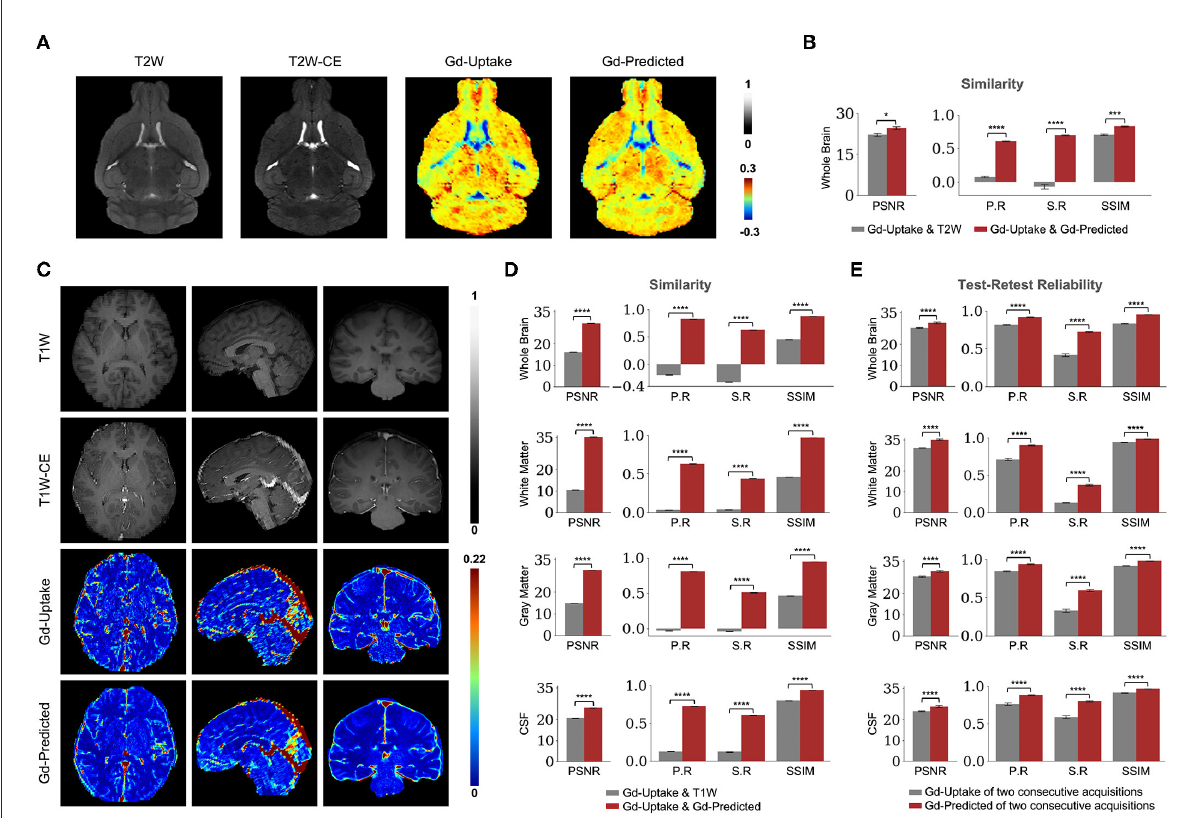
FIGURE3 Quantitative evaluation of the DeepContrast in the healthy mouse and human brains. (A) DeepContrast prediction (Gd-Predicted) highly concords with the ground truth GBCA-uptake map (Gd-Uptake) in the mouse brain. The non-contrast scans and the contrast-enhanced scans are displayed for reference. Color bars indicate the colormap and dynamic range used in the cross-sectional brain images. (B) The similarity between the model prediction and the ground truth, evaluated on all 6 scans in the test set using quantitative metrics, where the non-contrast (T2W) scans are used as the performance baseline. (C) DeepContrast prediction (Gd-Predicted) highly concords with the ground truth GBCA-uptake map (Gd-Uptake) in the cognitive normal human brain. Color bars indicate the colormap and dynamic range used in the cross-sectional brain images. (D) The similarity between the model prediction and the ground truth, evaluated on 179 scans of cognitively normal (CN) participants using quantitative metrics, where non-contrast (T1W) scans are used as the performance baseline. (E) DeepContrast shows higher test-retest reliability than the experimentally acquired Gd-Uptake ground truth. For all voxel-based metrics, only the voxels within the brains or subregions are used. SSIM is calculated on the minimum bounding box of the brains or subregions. Asterisks indicate level